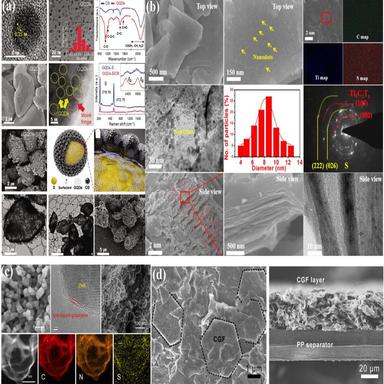
(a) Materials characterization of GQDs-S/CB and S/CB composites: TEM images of GQDs; the inset shows a histogram of the GQD size distribution. FTIR spectra of GQDs and CB. The peaks in this figure correspond to the various functional groups in the GQDs and CB. SEM images of GQDs-S and (GQDs-S/CB. Highresolution transmission electron microscope (HRTEM) images of the GQDs-S composites and GQD pattern (yellow circle). A Moiré pattern (red circle) is clearly visible in these TEM images, which was created by a